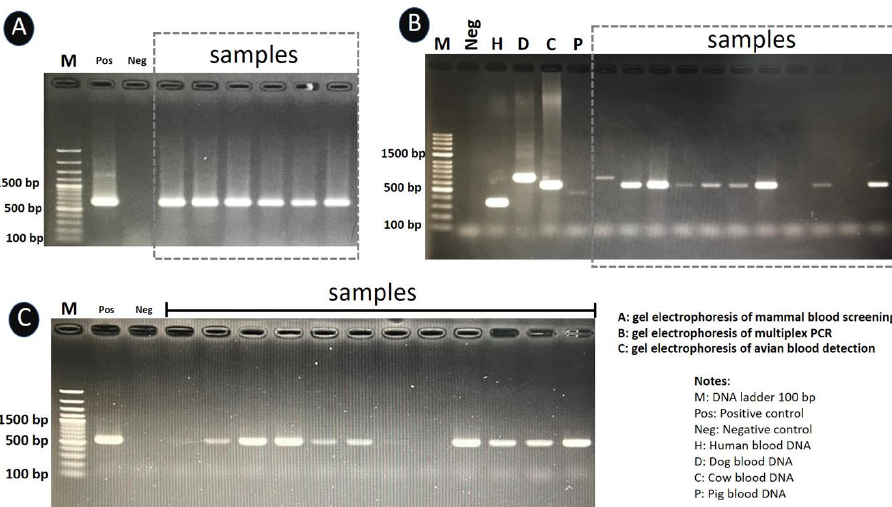
Figure 5. PCR amplification of the cytb gene against mammal blood DNA ( A ), human blood, pig blood, cow blood, dog blood DNA ( B ), and avian blood DNA ( C ) from Culicoides. Lane H, D, C, and P: human blood, dog blood, cow blood, and pig blood, respectively, lane M: DNA ladder (100 base pairs [bp]), lane Pos: positive control, lane Neg: negative control (no DNA template: Sterilized distilled water).